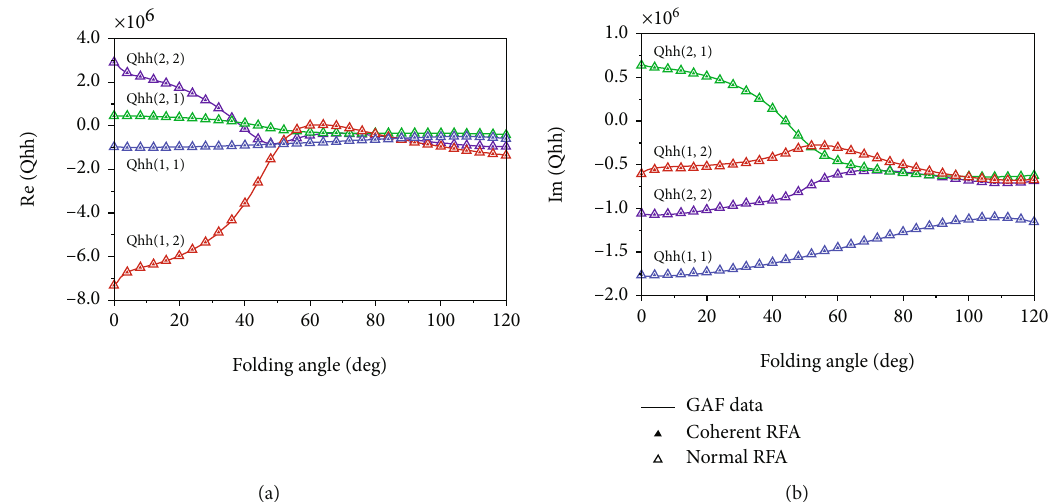
Figure 7: Comparison of approximated GAF obtained from normal RFA and coherent RFA with the original GAF data ( k = 0 : 25 ). (a) Real part. (b) Imaginary part.